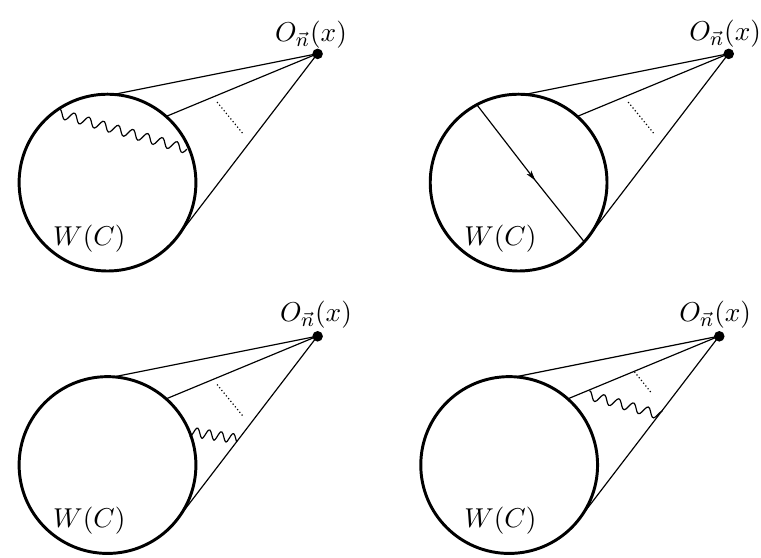
Figure 3 . Diagrams which do not contain interaction vertices including H or Q hypermultiplets and which therefore vanish in the di(cid:11)erence between the N = 2 and the N = 4 theory. Here there are some examples of diagrams which appear at order g 2 with respect to the tree-level amplitude A ~n , but vanish in the di(cid:11)erence (cid:14)A ~n